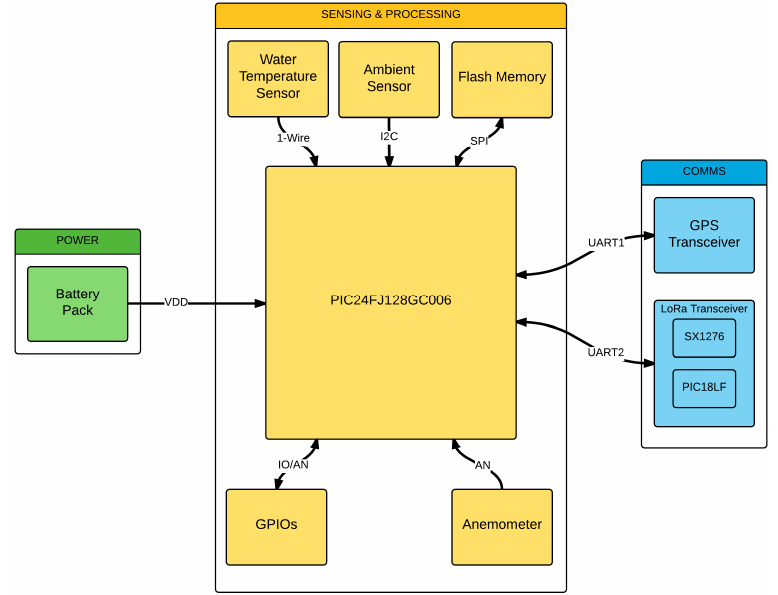
Figure 4. Block diagram of a sensor node’s peripheral connections.